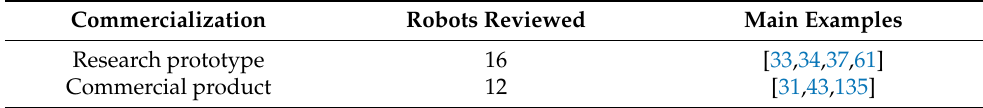
Table 6. Commercialization of agriculture